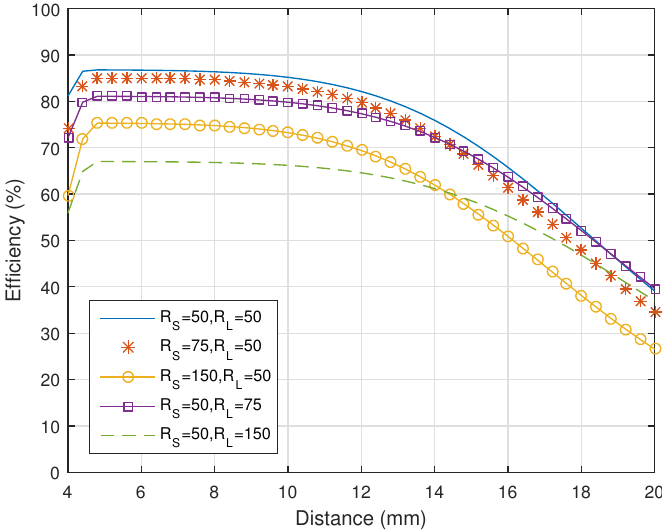
Figure 5. Maximum efficiency simulated results if the source and load resistance